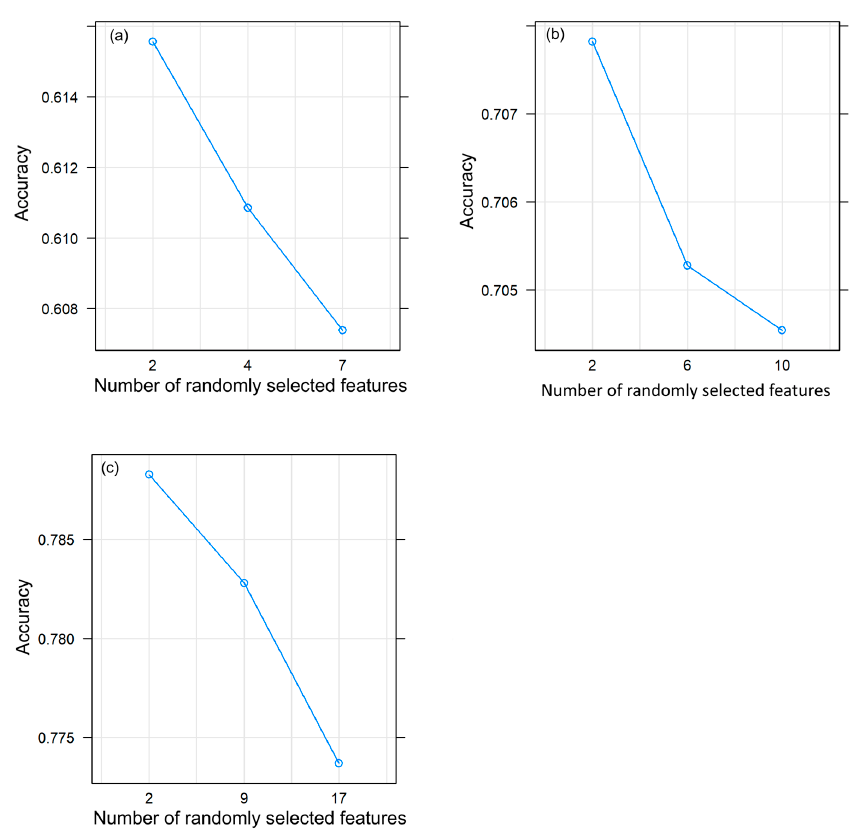
Figure 3. Tuning for the optimal number of features ( mtry ) to be involved in each split of the random forest classifier. The mtry values selected for random forest classification using ( a ) polarimetric SAR features, ( b ) textural features from grey-level co-occurrence matrix (GLCM), and ( c ) the combination of polarimetric SAR and GLCM textural features. The number of features with the highest accuracy was used to train the model.